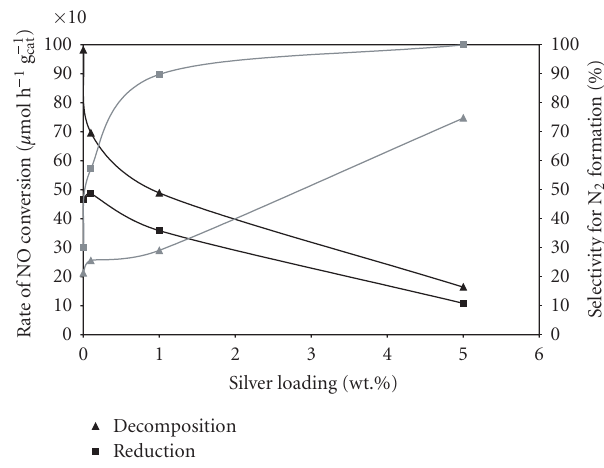
Figure 4: Rate of NO conversion and selectivity for N 2 formation over Ag-TiO 2 photocatalysts with varying silver concentrations un- der both decomposition and reduction conditions.